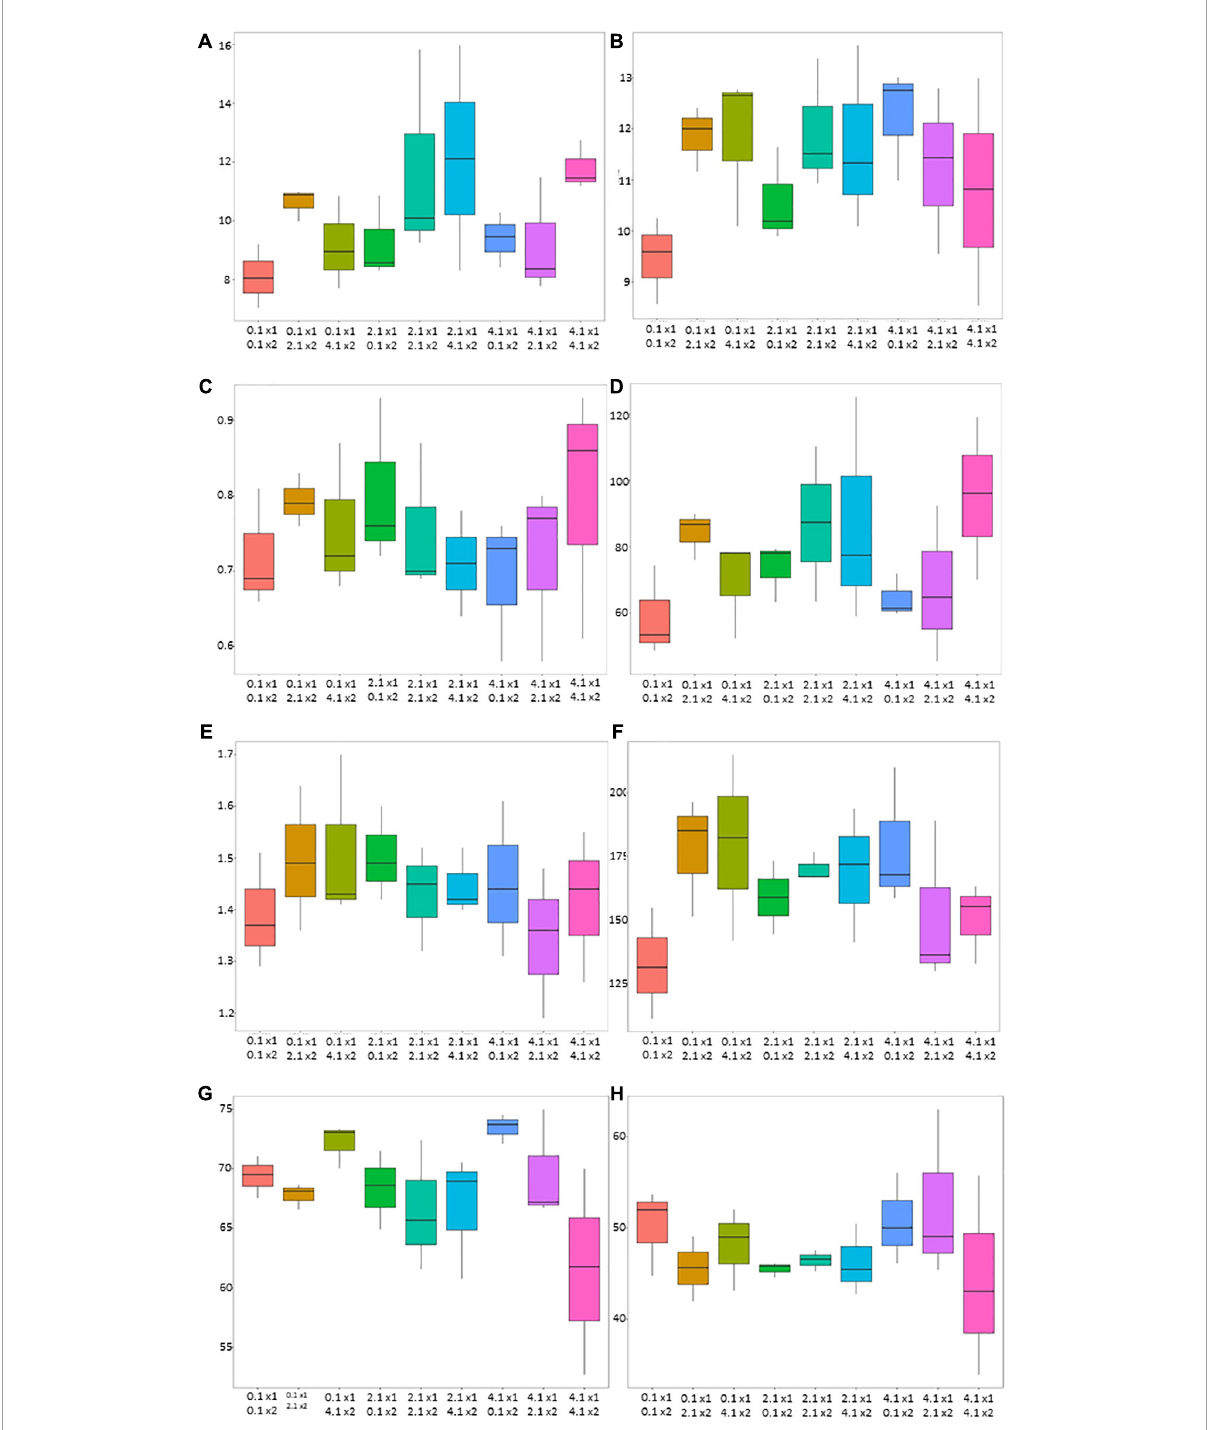
FIGURE1 Box plot diagrams of agronomic parameters for AMF and Bacillus megaterium treatments on maize ( Zea mays L.). The X -axis describes the combination of AMF and B. megaterium doses (0.1 kg ha − 1 , 2.1 kg ha − 1 , and 4.1 kg ha − 1 ) while the Y -axis represents the values for maize biomass (mg ha − 1 ) (A) , grain yield (mg ha − 1 ) (B) , biomass nitrogen concentration (%) (C) , biomass nitrogen-uptake (kg ha − 1 ) (D) , grain nitrogen concentration (%) (E) , grain nitrogen-uptake (kg ha − 1 ) (F) , NHI (G) , and NutE (H) . Each box line corresponds to the median of the data while the ends of the box show the upper (Q3) and lower